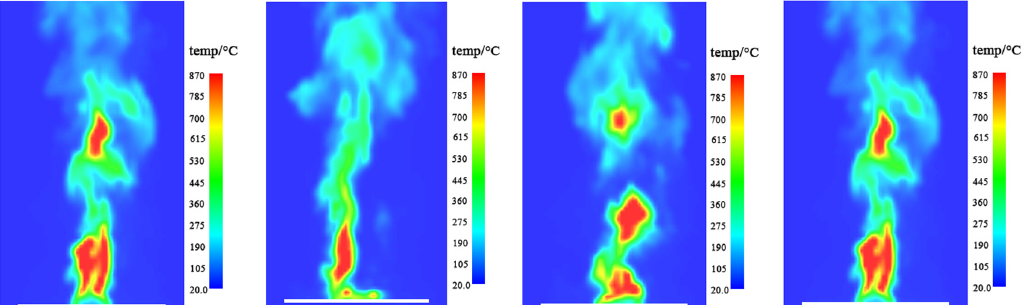
Figure 6. Instantaneous temperature contours of pool fire.